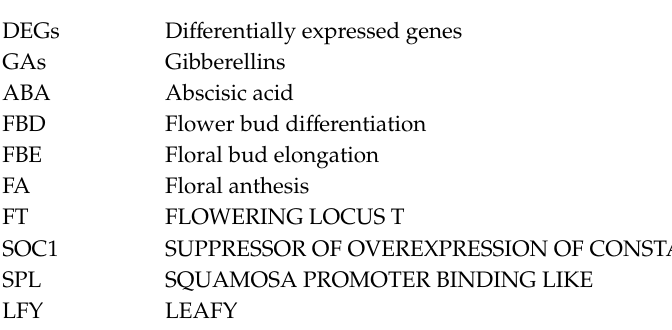
development. Table S3. Functional annotation for flower development. Table S4. KEGG pathway enrichment analysis of DEGs for FBE vs. FBD. Table S5. KEGG pathway enrichment analysis of DEGs for FA vs. FBE. Table S6. KEGG pathway enrichment analysis of DEGs for FA vs. FBD. Table S7. The TF genes were identified in three development stages. Table S8. The five TF families most highly represented in the DEGs. Table S9. The identified spectra matched unique peptides. Table S10. The identified proteins in FBD, FBE, and FA stages. Table S11 KEGG pathway enrichment analysis of DAPs of FBE vs. FBD. Table S12 KEGG pathway enrichment analysis of DAPs of FA vs. FBE. Table S13 KEGG pathway enrichment analysis of DAPs of FA vs. FBD. Table S14. Primer sequences and annealing temperatures used for